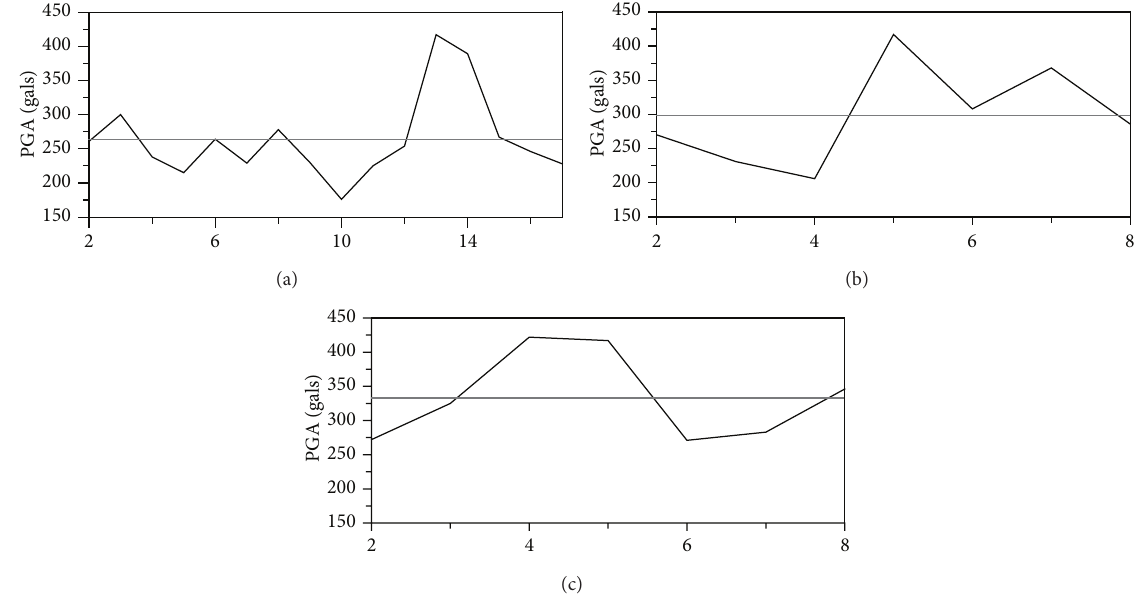
Figure 8: Variation of peak ground acceleration with respect to mean value by changing (a) nucleation point, (b) velocity, and (c) dip